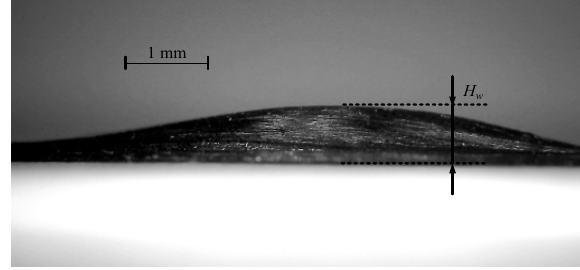
Figure 9. The height of the fiber waviness.